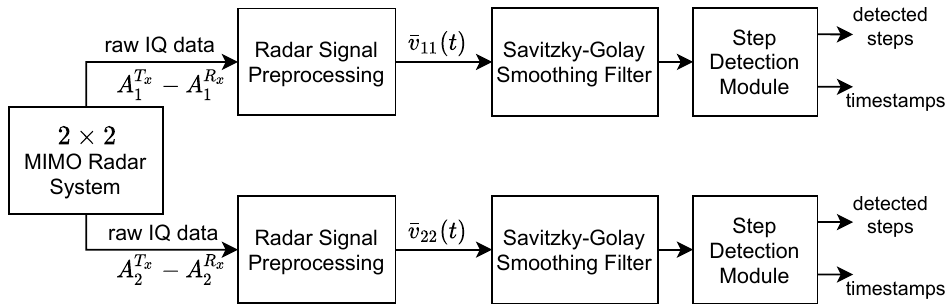
Figure 10. The block diagram of the RF-based step counter for a 2 × 2 MIMO radar